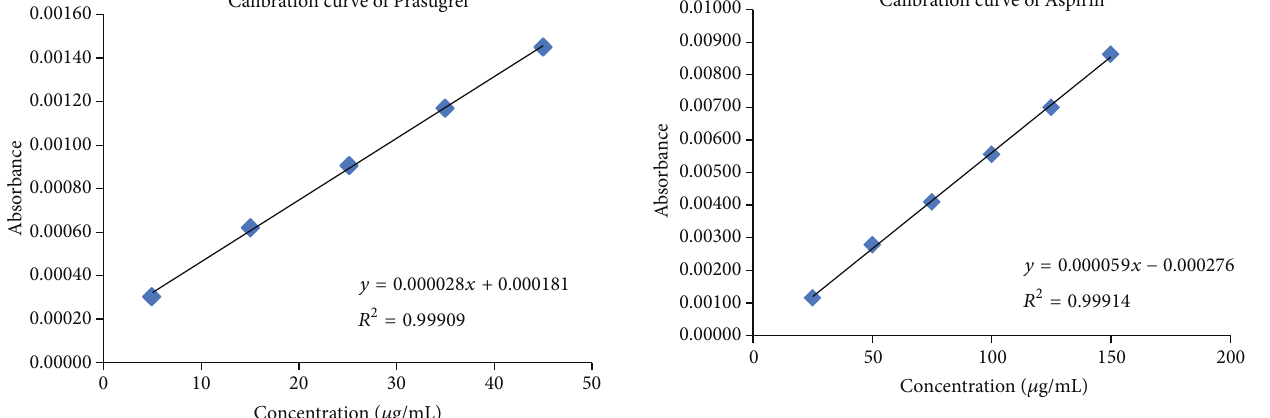
Figure 6: Calibration curve of Aspirin (25–150 𝜇 g/mL) by second order derivative method.